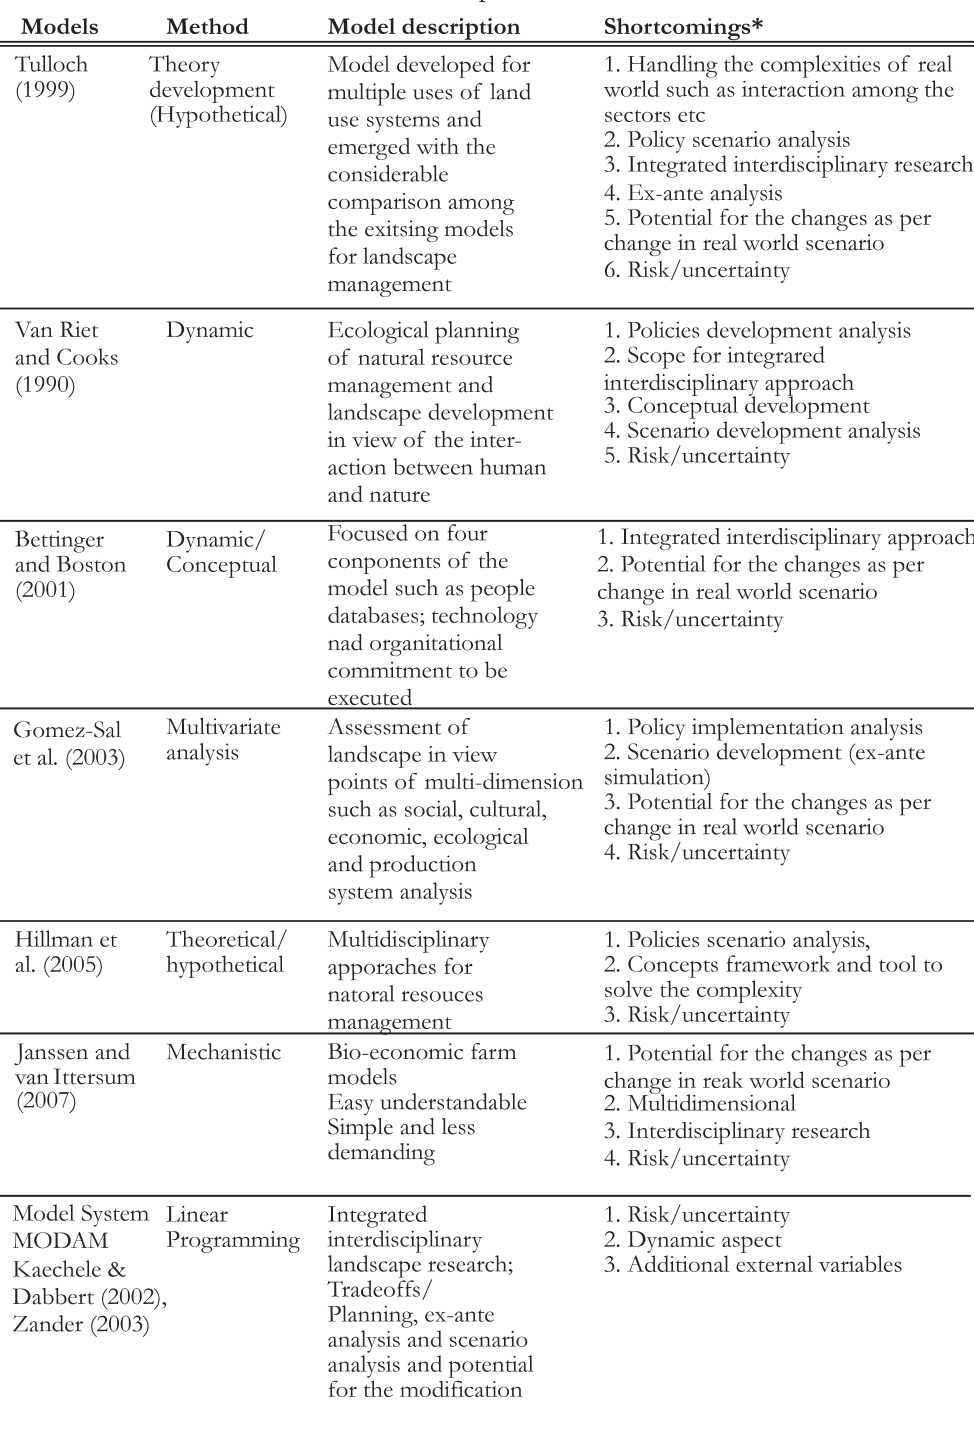
Table 1. Comparison between process models from the literature and proposed conceptual model